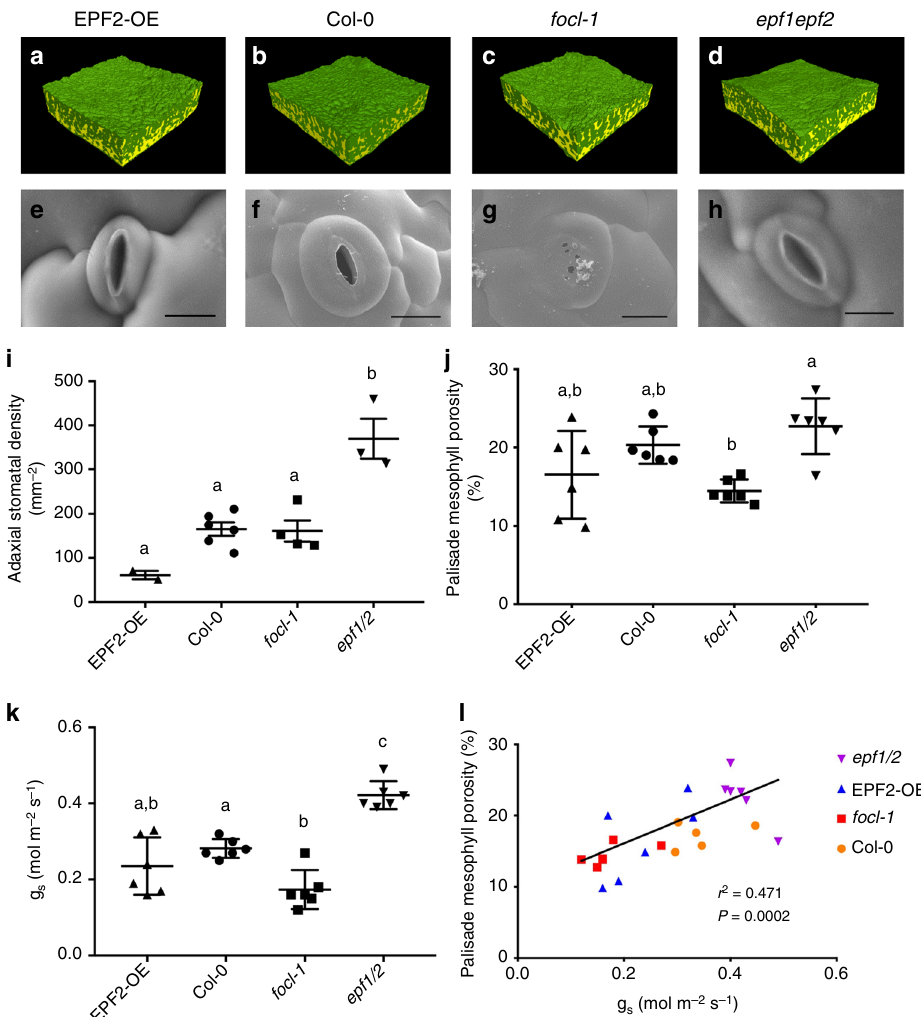
Fig. 5 Mesophyll porosity is modulated by gas exchange through stomatal pores. a – d 3D microCT renderings of tissue blocks (resolution = 2.75 μ m; samples = 1.1 mm 2 ) and ( e – h ) exemplar SEM images of stomata from leaves of Arabidopsis EPF2-OE , Col-0 , focl1-1 and epf1epf2 lines (scale bars = 10 μ m). Means and standard deviation are shown for ( i ) stomatal density (ANOVA, F (3,11) = 19.17, p < 0.0001), ( j ) palisade mesophyll porosity (ANOVA, F (3,20) = 6.329, p = 0.0034) and ( k ) stomatal conductance, g s (ANOVA, F (3,20) = 26.22, p < 0.0001) for the Arabidopsis lines in a – d , with n = 6 except for stomatal density where n = 4 ( focl-1 ), n = 2 ( EPF2-OE ) and n = 3 ( epf1epf2 ). Col-0 data are as in ref. 13 . Lines indicated with the same letter cannot be distinguished from each other at the p < 0.05 con fi dence limit (posthoc Tukey). l Palisade mesophyll porosity is plotted against stomatal conductance, g s , for individual leaf samples from the four Arabidopsis lines, as indicated. Linear regression results are